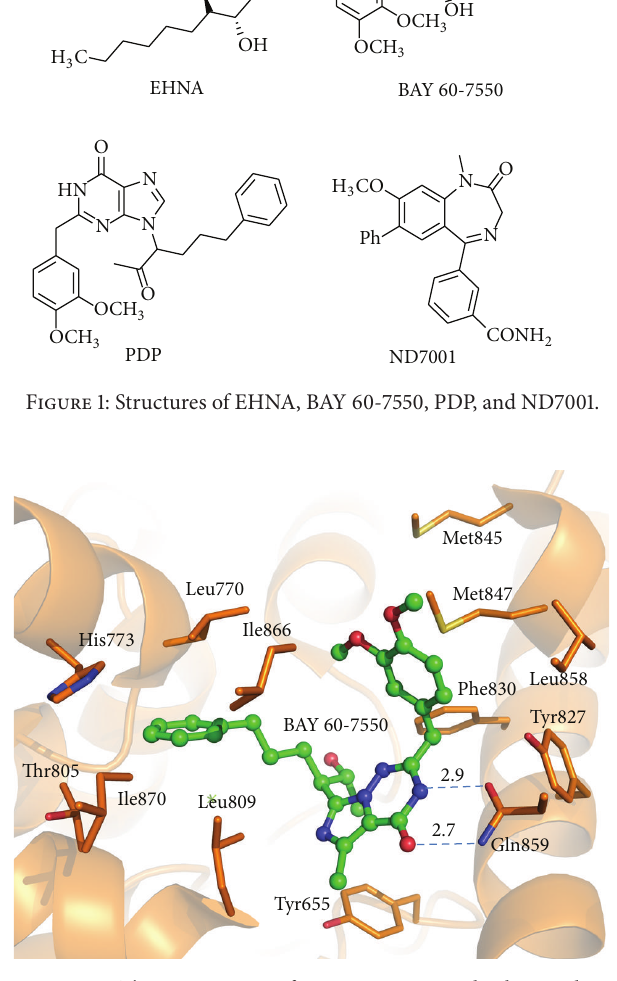
Figure 2: The interaction of BAY 60-7550 with the catalytic domain of PDE2 (PDB ID: 4HTX). The BAY compound is rendered with green color scheme. Residues that form key interactions with BAY compound are rendered with orange color scheme. The environmental protein surrounding is rendered in orange. For the convenience of display, some residues are not